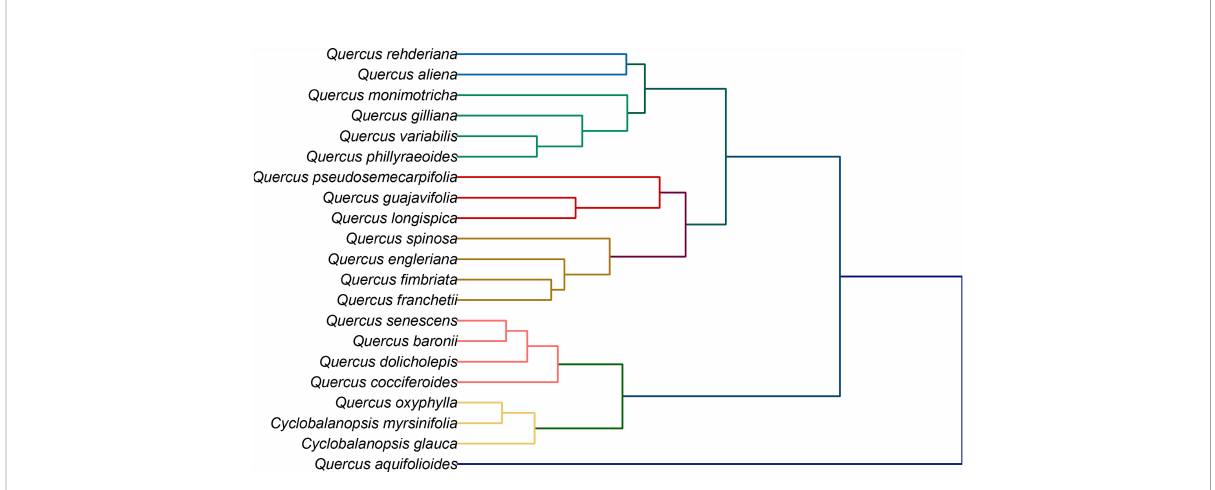
FIGURE 6 Dendrogram of Q. rehderiana, Q. aliena, Q. monimotricha, Q. gilliana, Q. variabilis, Q. phillyraroides, Q. pseudosemecarpofolia, Q. guajavifolia, Q. longispica, Q. spinosa, Q. engleriana, Q. fi mbriata, Q. franchetii, Q. senescens, Q. baronii, Q. dolicholepis, Q. cocciferoides, Q. oxyphylla, Q. aquifolioides, Cyclobalanopsos myrsinifolia and Cyclobalanopsis glauca based on electrochemical fi